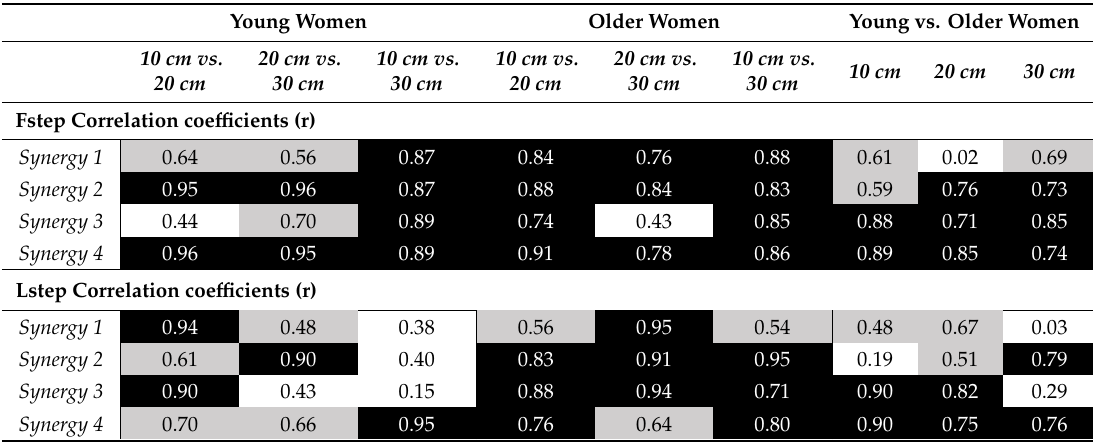
Table 1. Similarity index (Pearson’s r ) of synergy weightings, across step heights for each age group, and across age groups for each step height. Results are displayed separately for forward stepping (Fstep) and lateral stepping (Lstep). Grey = marginal similarity ( r > 0.45) and black = significant similarity ( r >